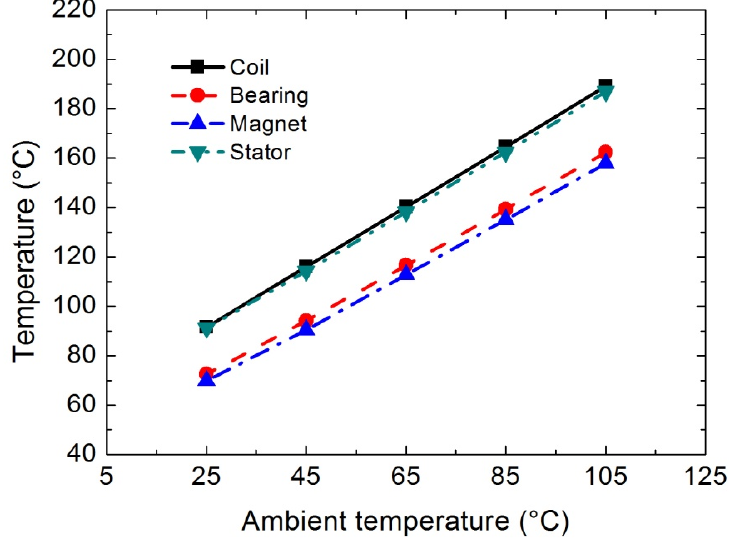
Figure 11. Temperature variations with respect to the ambient temperature of